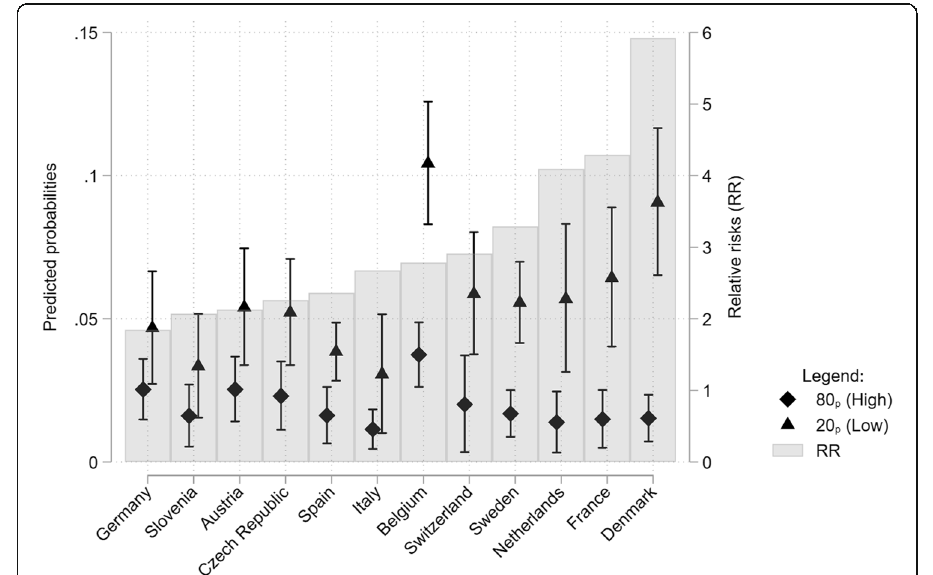
Fig. 5 Predicted probabilities (left axis) and 95% confidence intervals for low educated (triangles) and high educated (diamonds) and associate relative risks (bars; right axis) of being in a nursing home by country, controlling for respondent ’ s